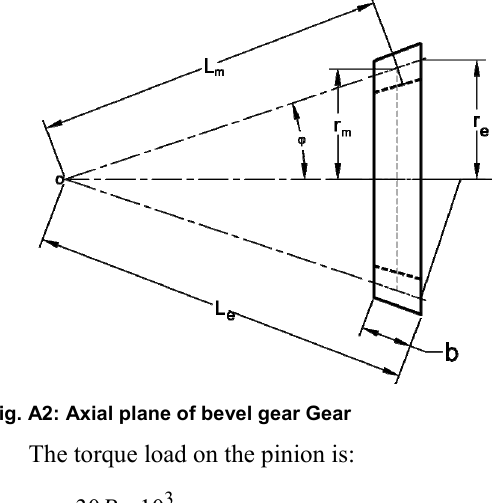
Fig. A1: Forces in bevel gear